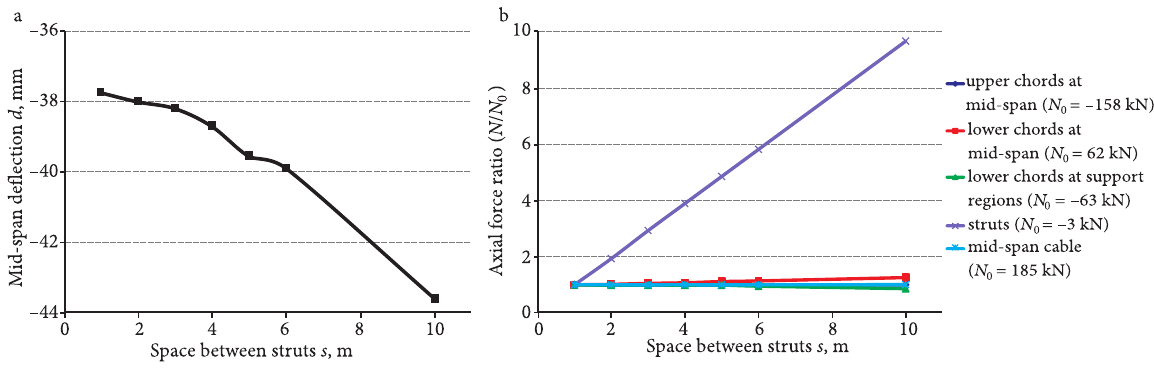
Fig. 3. Variation of mid-span deflection and axial force ratio with space between struts (when struts number is even): a – mid-span deflection versus the space between struts; b – axial force ratio versus the space between struts